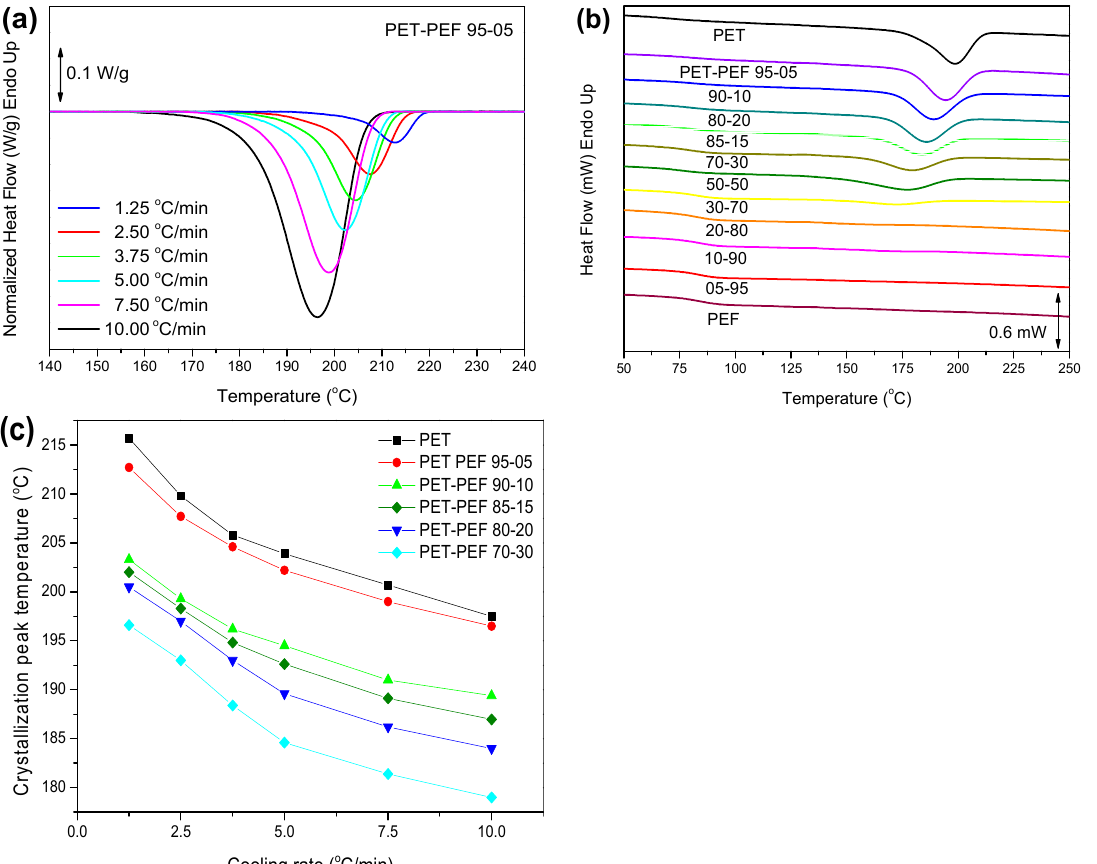
Figure 9. ( a ) DSC traces of non-isothermal crystallization of PET-PEF 95-05 at various cooling rates, ( b ) DSC traces of the non-isothermal crystallization of all blends under cooling at 10 ◦ C/min, ( c ) peak crystallization temperatures versus cooling rate for the blends that were